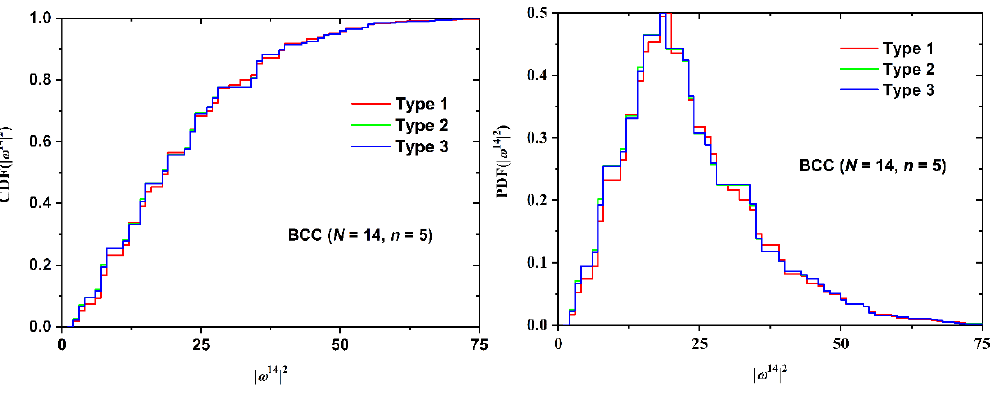
Figure 16. (Left Panel) Cumulative distribution function (CDF) and (Right Panel) the folded variant of the square end-to-end distance for the BCC restricted lattice for SAWs of fixed length ( N = 14) and number of layers between confining planes ( n = 5). Different curves correspond to different SAW origins (Types).